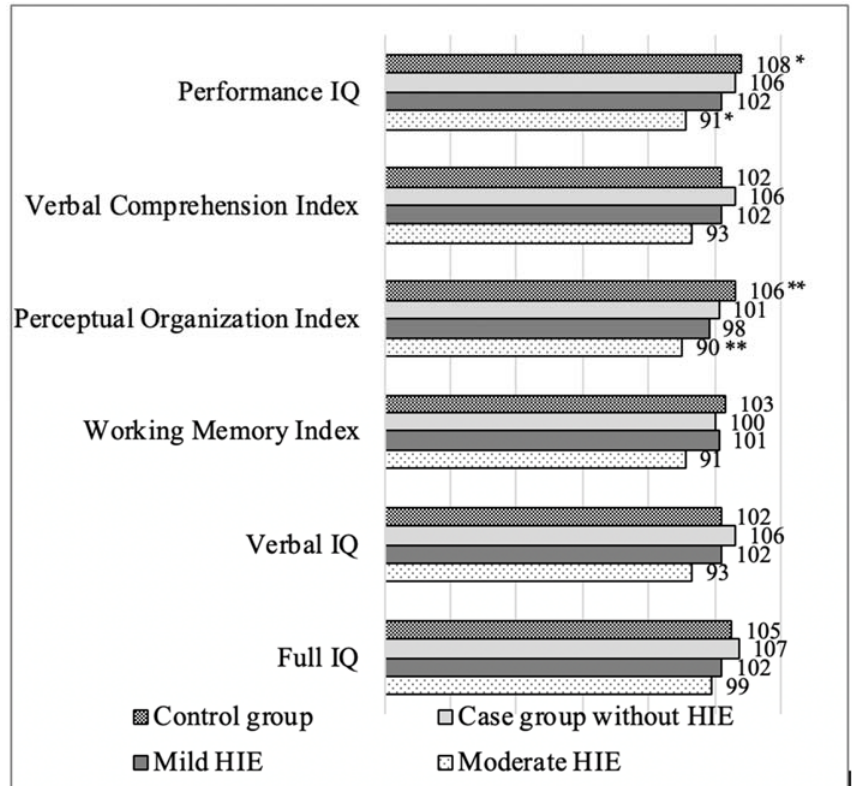
Figure 2. Mean IQ coefficient scores at an early school age in children with respect to HIE grade. The text continues here. IQ—intelligence quotient; HIE—hypoxic ischemic encephalopathy; * p = 0.02; ** p = 0.021.